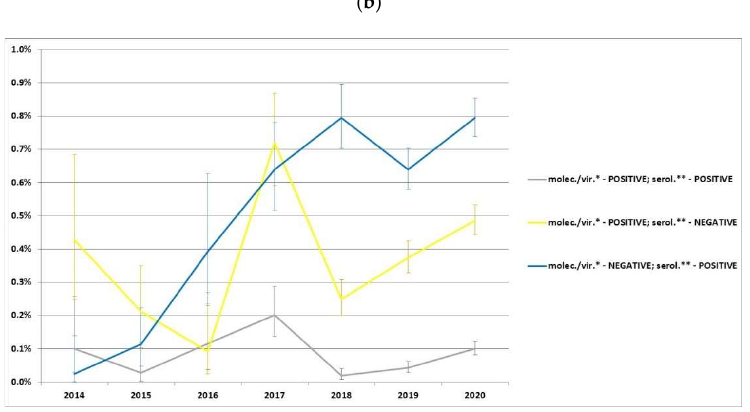
Figure 3. ASF-positive wild boars analyzed by both type of tests (molecular/virus and serological): ( a ) quantitative division of ASF-positive wild boars; ( b ) percentage of ASF-positive wild boars in relation to all analyzed wild boars; ( c ) percentage of ASF-positive wild boars in relation to wild boars analyzed with both type of tests.